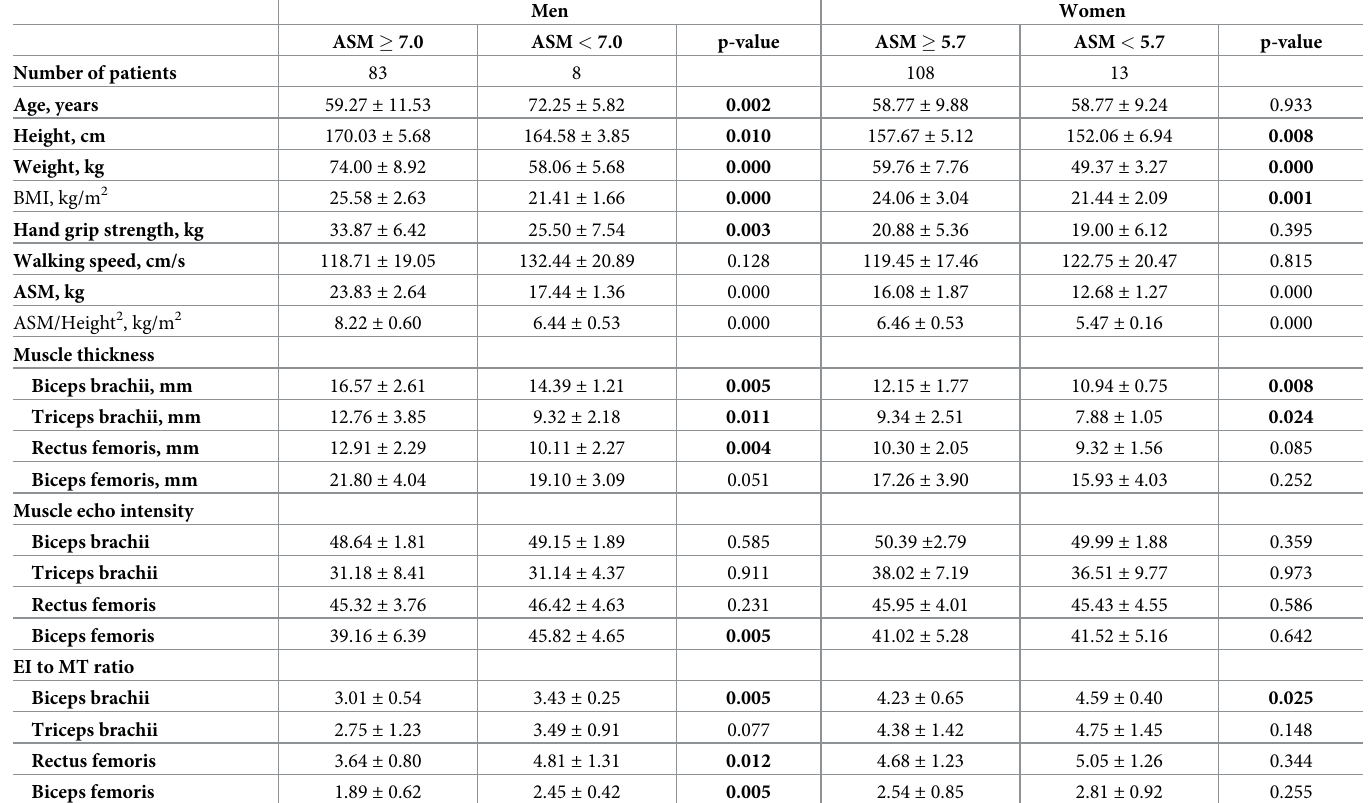
Table 6. Comparison between subjects in the normal and low ASM